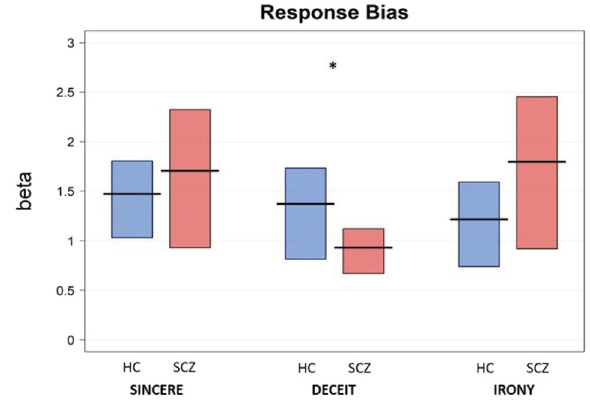
Fig. 2 Response bias (Beta) values for sincere, deceitful, and ironic communicative acts in SCZ and HC groups. Note: The horizontal line corresponds to the mean of the different groups (SCZ = schizophrenia, HC = healthy controls) for the different communicative acts (Sincere: SCZ = 1.71 (sd = 1.63), HC = 1.47 (0.96), Cohen ’ s d : − 0.17 [ − 0.74, 0.39]; Deceit: SCZ = 0.93 (0.55); HC = 1.37 (1.06), Cohen ’ s d : 0.52 [ − 0.06, 1.09]; Irony: SCZ = 1.80 (1.77), HC = 1.22 (1.00), Cohen ’ s d : − 0.40 [ − 0.97, 0.17]), and the rectangle represents the Bayesian highest density interval. Higher Beta values indicate more conservative responding, while lower Beta values indicate more liberal responding. ** p < 0.01 * p < 0.05.